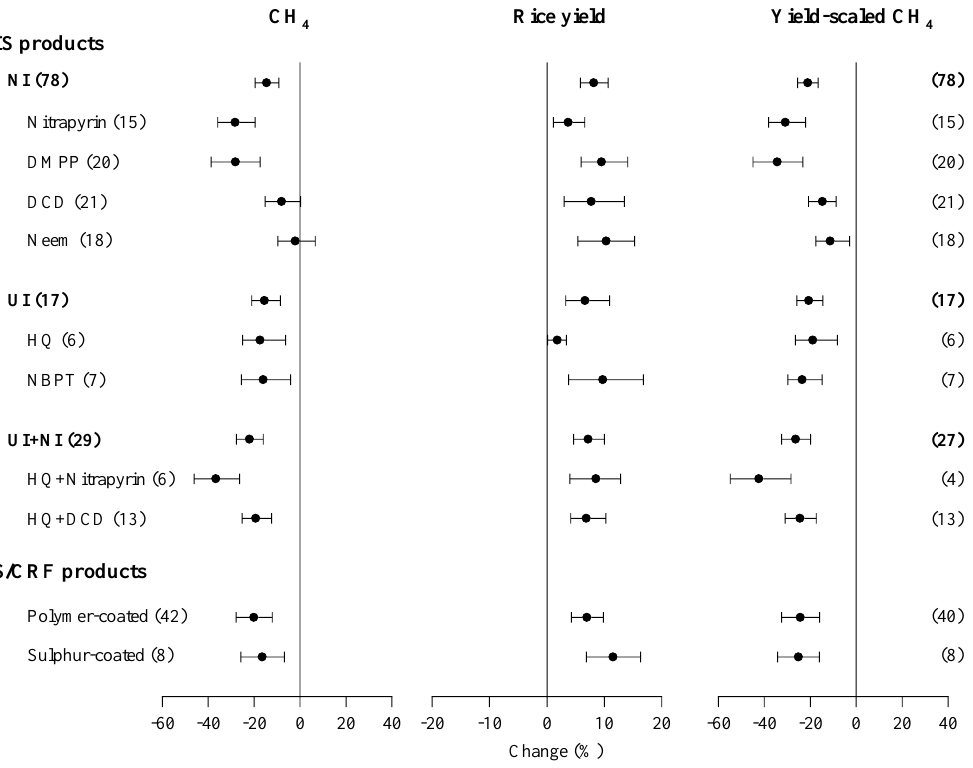
Figure 2. Effects of EENF products on CH 4 , rice yield, and yield-scaled CH 4 emission from rice fields.